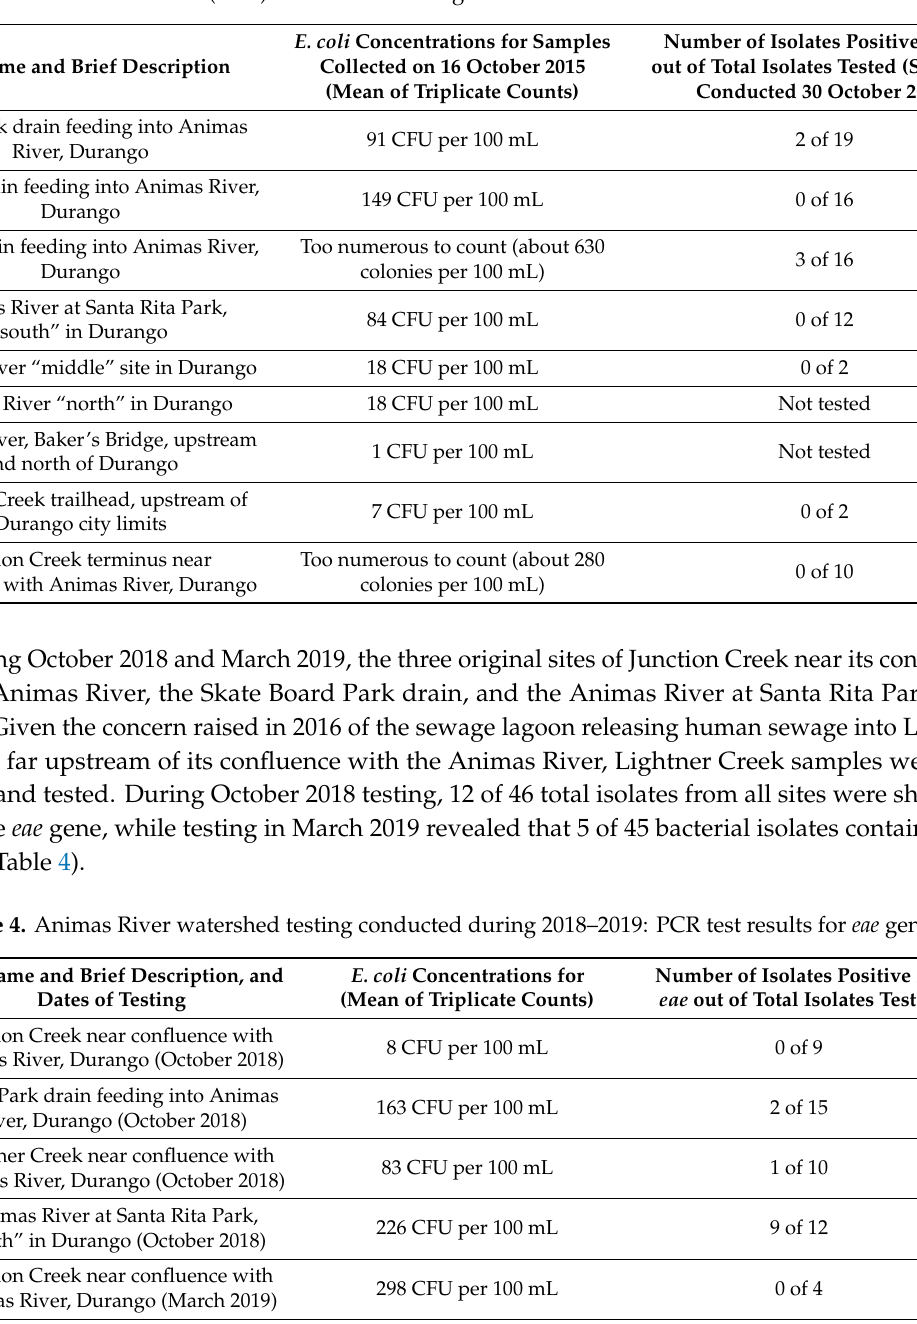
Table 3. Animas River watershed testing conducted during October 2015: E. coli concentrations and polymerase chain reaction (PCR) test results for eae gene.